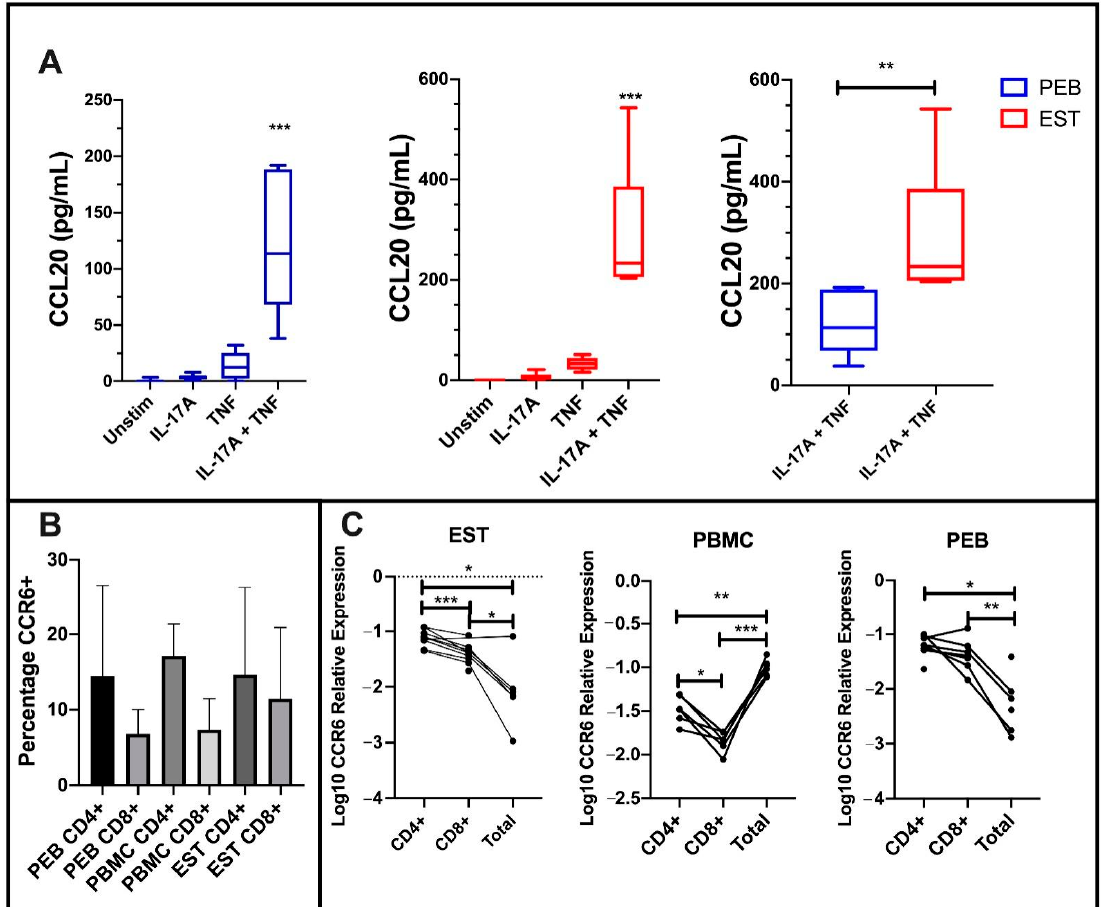
Figure 6. C-C Motif Chemokine Ligand 20 (CCL20) protein expression from stimulated mesenchymal stem cells (MSCs) and CCR6 expression on CD4 and CD8 T-cells at the enthesis. ( A ) Co-stimulation of both peri-entheseal bone (PEB) and entheseal soft tissue (EST) MSCs with IL-17A and TNF significantly increased CCL20 protein expression compared to the unstimulated control (Friedman’s Test with Dunn’s Multiple Comparisons, n = 6). EST MSCs secrete significantly more CCL20 than PEB MSCs (Mann–Whitney Test, n = 6). ( B ) CD4+ T-cells display a higher percentage expression compared to CD8+ T-cells in PEB, EST, and peripheral blood mononuclear cells (PBMC). ( C ) Transcript analysis shows higher levels of CCR6 expression on CD4 cells compared to CD8 (RM One-Way ANOVA with Tukey Post-Hoc Test, PEB n = 8, EST n = 9, PBMC n = 6). Total represents all CD45+ cells from the tissue. IL-17A used at 100 ng/mL and TNF at 10 ng/mL. * = p < 0.05, ** = p < 0.01, and *** = p < 0.001.